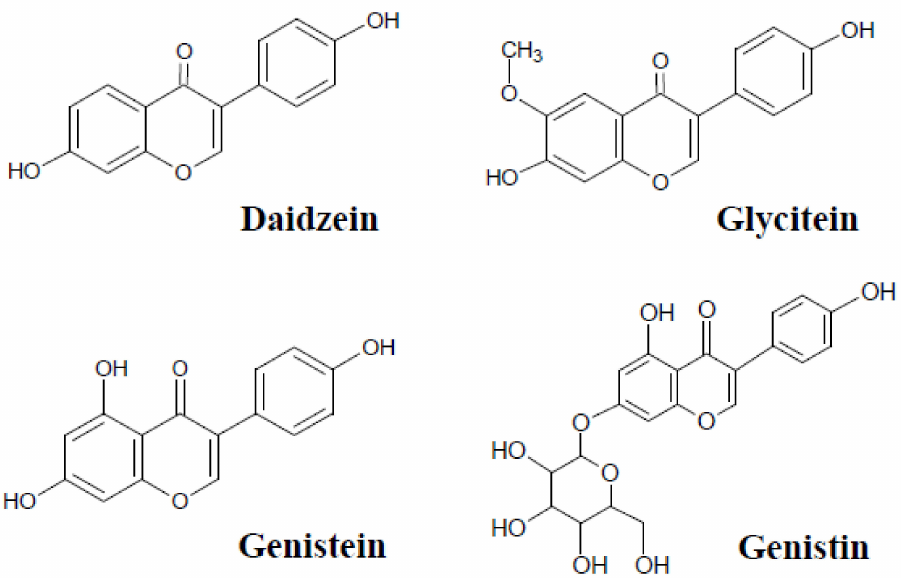
Scheme 1. Structure of the four soy